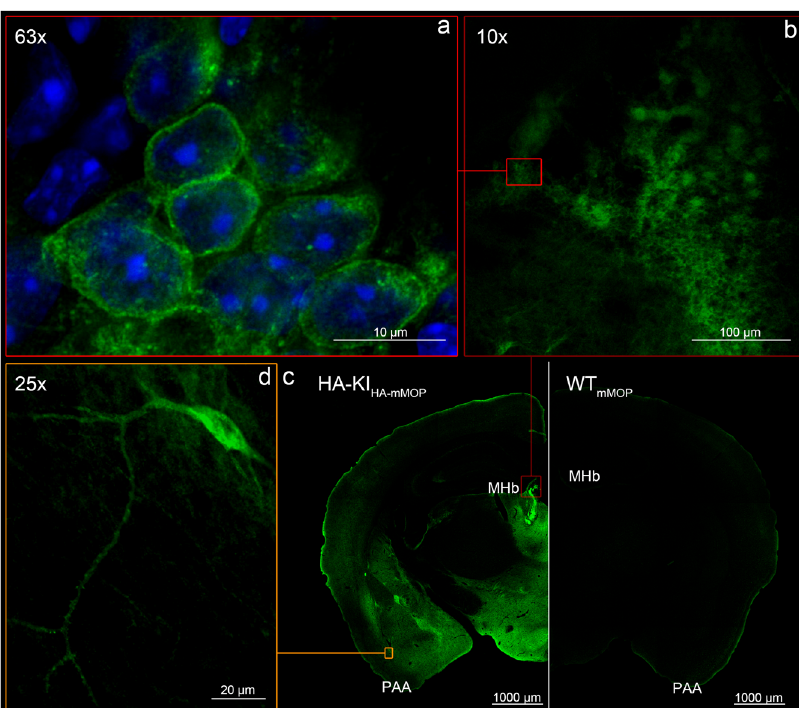
Fig. 2 Immunostaining for HA-MOP. a , b HA-MOP localization on cell bodies of habenula neurons (10× and 63× lenses). c 40 µ m brain sections from adult HA-MOP mouse compared to wild-type. d Cell bodies and dendrites in the amygdala (25× lenses). cSlices were stained with Cy3-labeled (550 nm) secondary antibody and pseudo-colored afterward. Scale bars as indicated in each picture. MHb medial habenula, PAA piriform-amygdalar